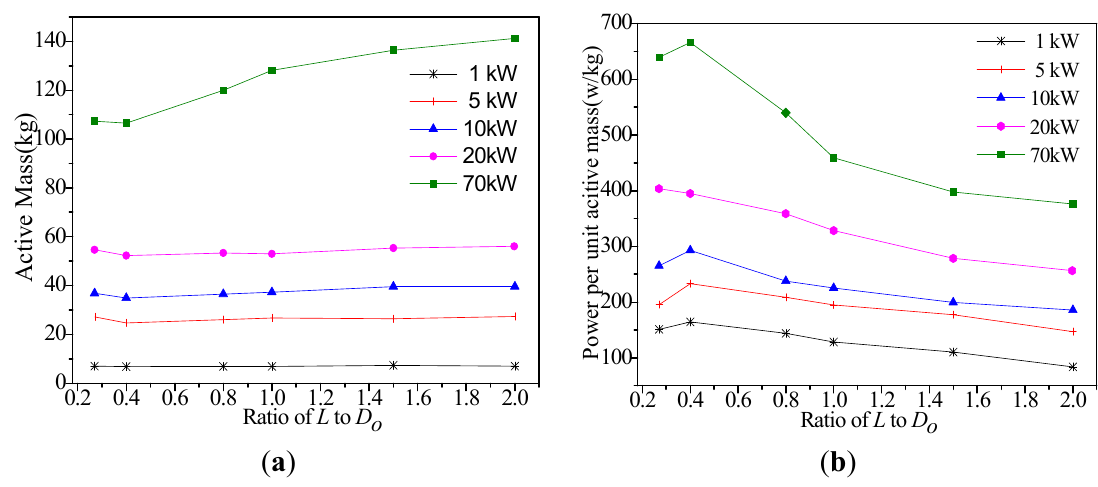
Figure 4. Influences of the ratio k on ( a ) active mass of material; and ( b ) power per unit active mass.